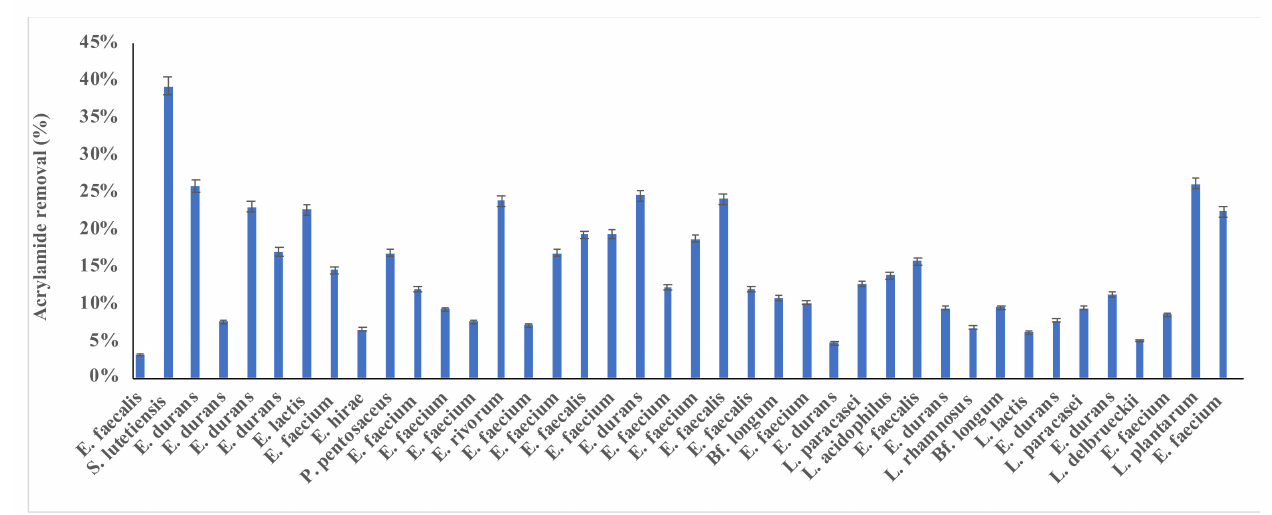
Figure 1. Acrylamide removal (%) of 40 newly isolated lactic acid